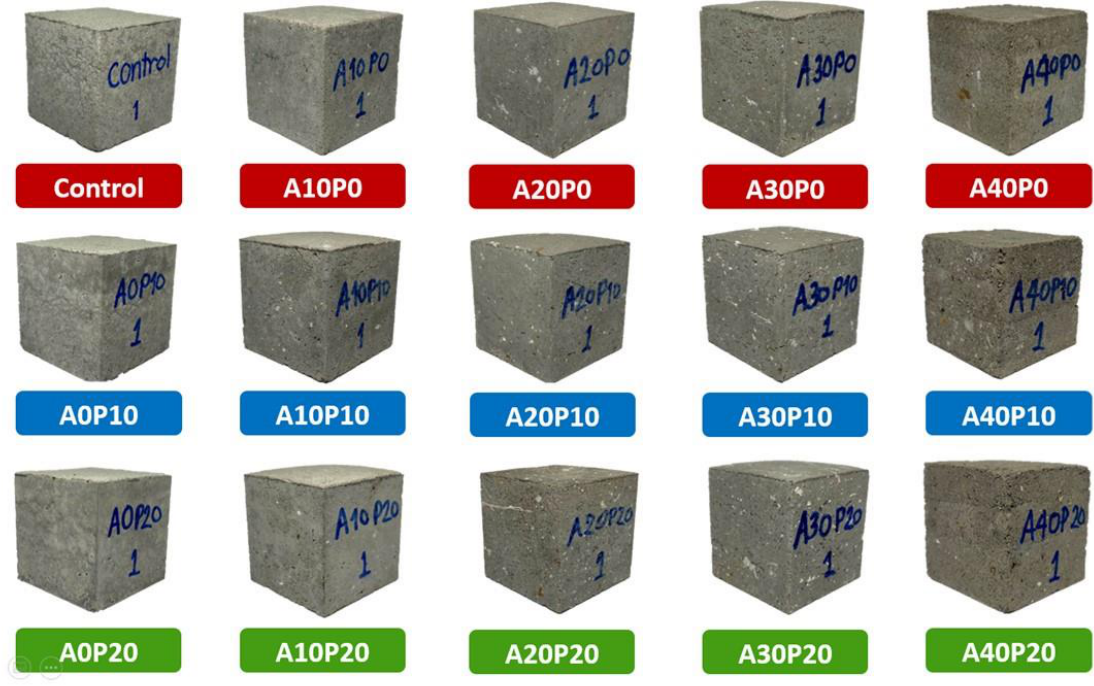
Figure 5. General appearance of mortar specimens.